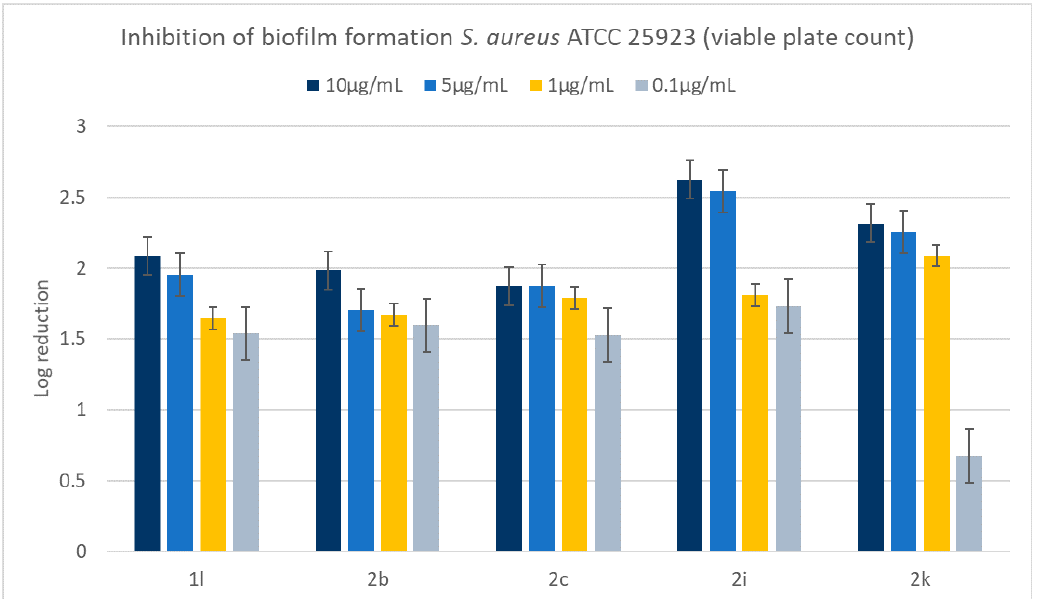
Figure 2. Inhibition of staphylococcal biofilm formation (viable plate count). Activity expressed in terms of log reduction. Each value is the average (reported with the SD values and error bars) from at least two independent experiments, p < 0.05.